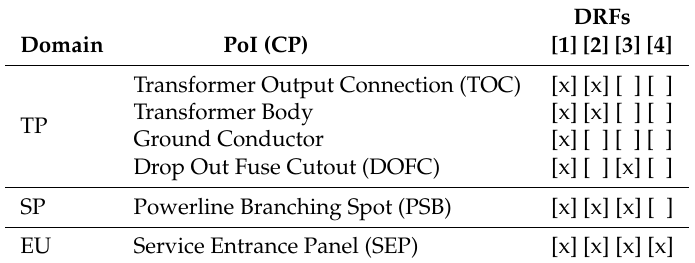
Figure 4. LVC electric scheme (single line diagram) describing the SmartLVGrid vision about distribution system composition (Domains division). Table 2. Designation of the DRFs executed in the Points of Interface (PoIs) in each LVC